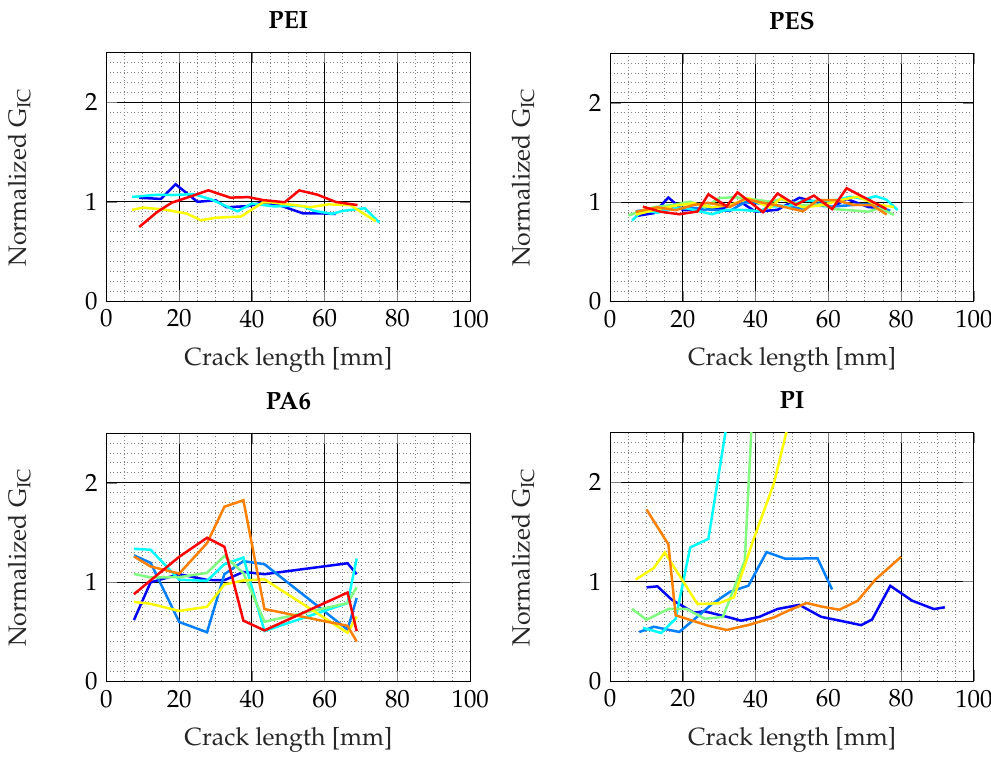
Figure 11. R-curves of different thermoplastic films in the DCB test. Every line shows the R-curve of one single